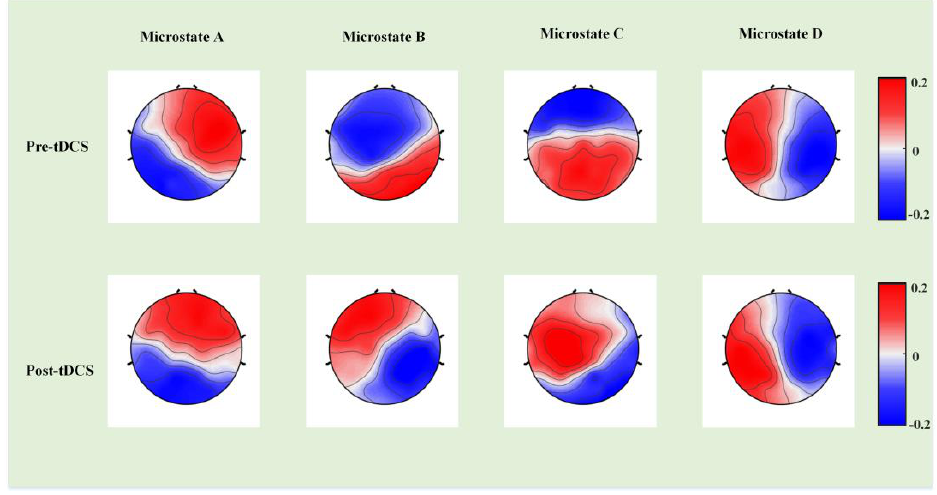
Figure 6. The template maps of the four microstate classes in the control group before and after tDCS.